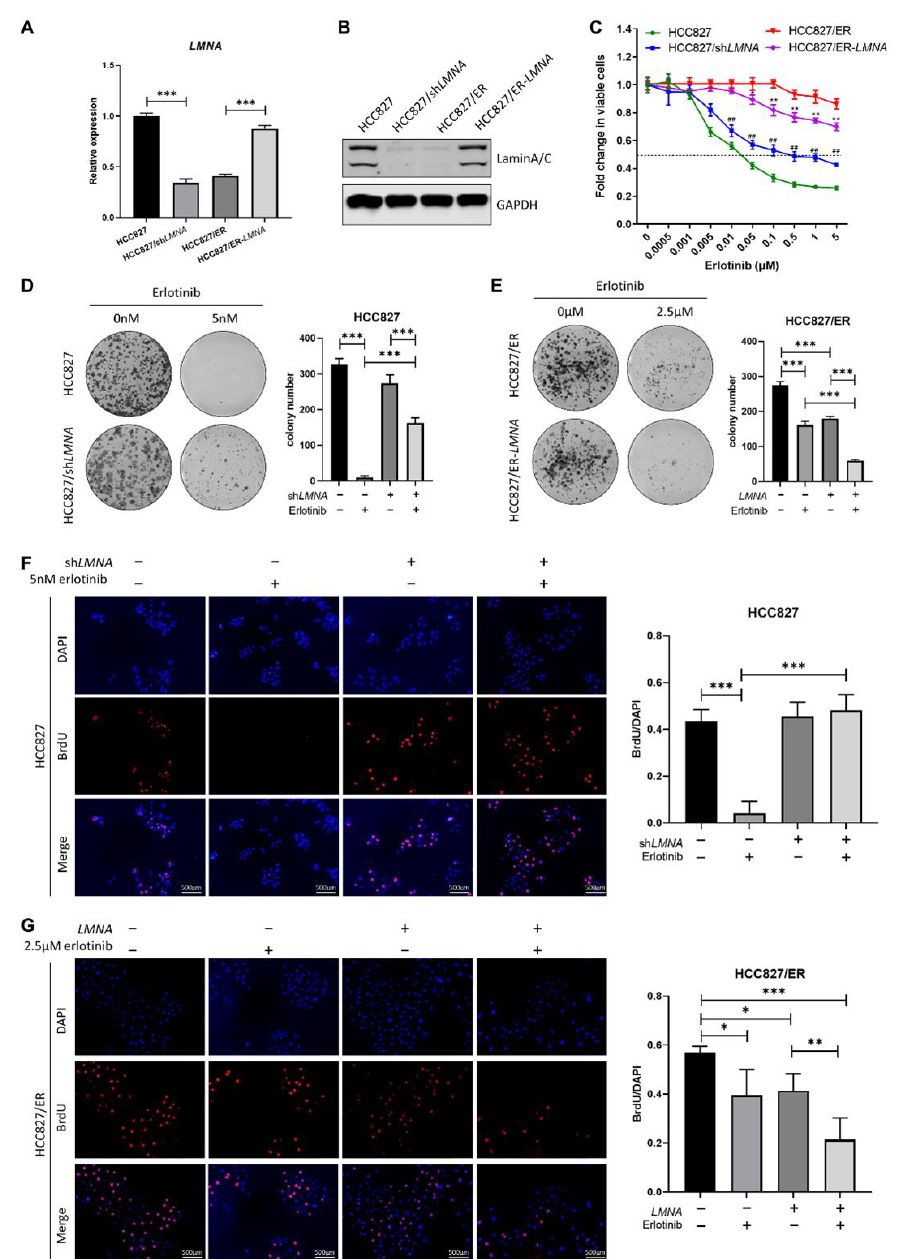
Figure 3. Effect of LMNA on cell proliferation and resistance to erlotinib in HCC827 and HCC827/ER cells. ( A ) The mRNA levels and ( B ) protein expression of LMNA were determined by qRT-PCR and Western blot after lentiviral infections of HCC827 cells with shRNA and HCC827/ER cells with LMNA , respectively. ( C ) Effect of LMNA knockdown or overexpression on erlotinib efficacy was determined by MTT assay. Data are presented mean ± SD from three independent experiments: ** p < 0.01 versus HCC827/ER cells, ## p < 0.01 versus HCC827 cells. ( D , E ) A colony-formation assay was performed to investigate the antiproliferation of LMNA in combination with indicated erlotinib in parental and resistant cells. Data are presented as mean ± SD from three independent experiments. Significant differences are indicated as follows: Student’s t -test, *** p < 0.001. ( F ) and ( G ) A BrdU incorporation assay was performed in HCC827 and HCC827/ER cells to assess the antiproliferative effect of LMNA combined with 5 nM or 2.5 µ M erlotinib after 24 h of incubation, respectively. Data are presented as mean ± SD from three independent experiments. Significant differences are indicated as follows: Student’s t -test, * p < 0.05, ** p < 0.01, *** p <